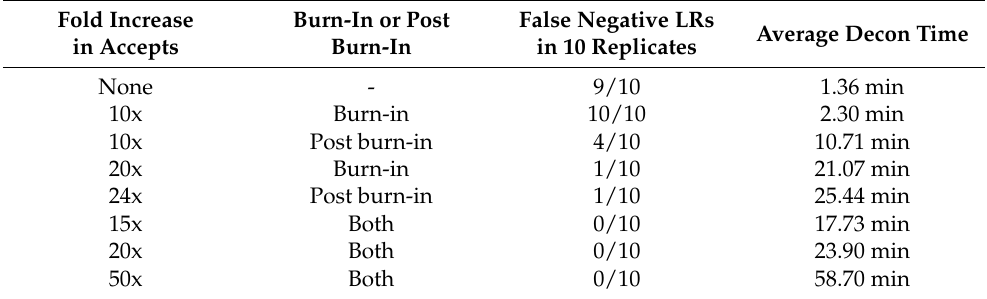
Table 5. Effect of increasing MCMC burn-in and post burn-in accepts on the false negative rate for 4-person compound LRs calculated for a 250 pg 4:3:2:1